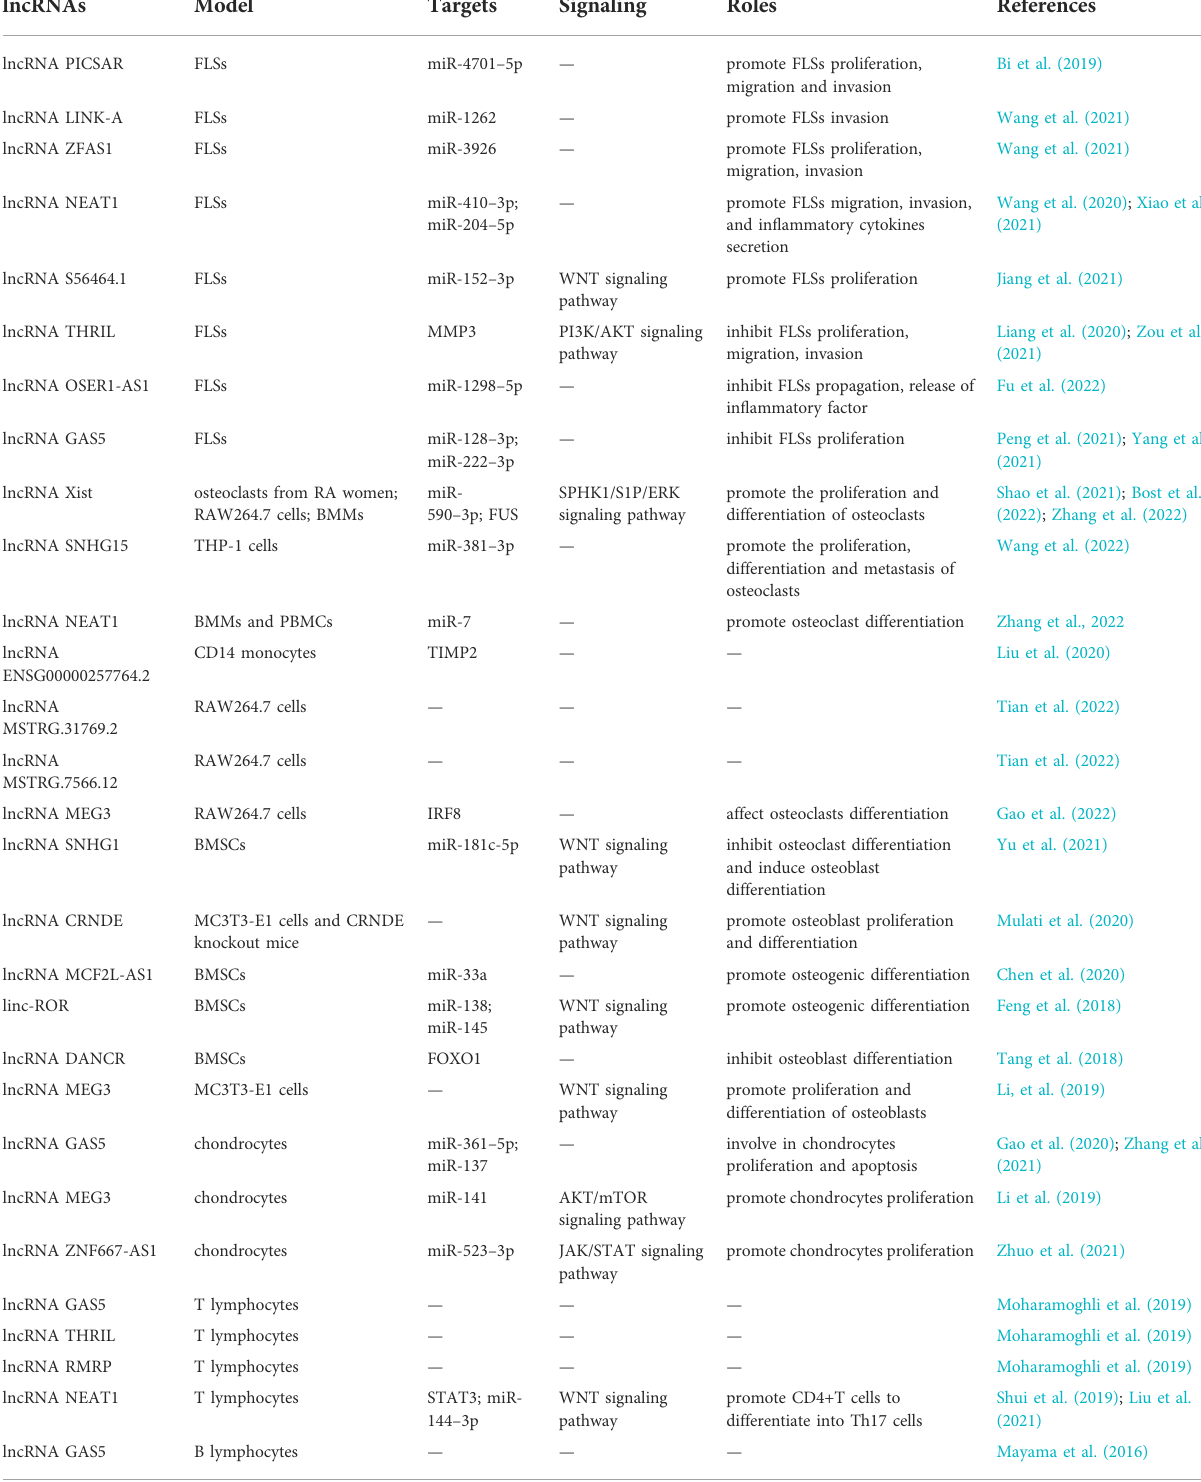
TABLE 1 Roles of lncRNAs in joint destruction of